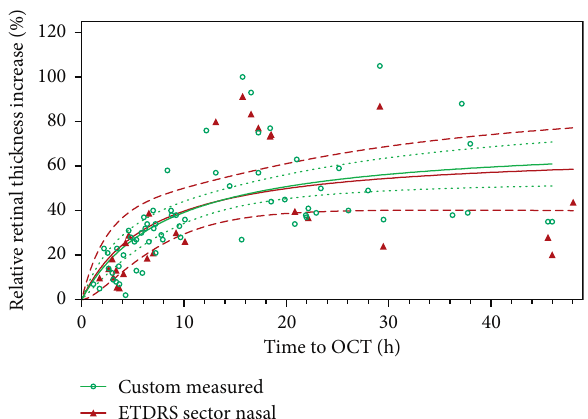
Figure 1: Representative time-dependent increase of the relative retinal thickness over 48 hours compared between manual and automatic measurements in the nasal sector. Relative retinal thickness increase (RRTI) in central retinal artery occlusion (CRAO) is caused by retinal ischemia. This figure shows the nasal ETDRS sector ( n � 28) represented by the triangle and manually measured values from the previous study [5] represented by circles ( n � 66). The x -axis represents time to OCT (TTO) and the y -axis the relative retinal thickness increase in percent.